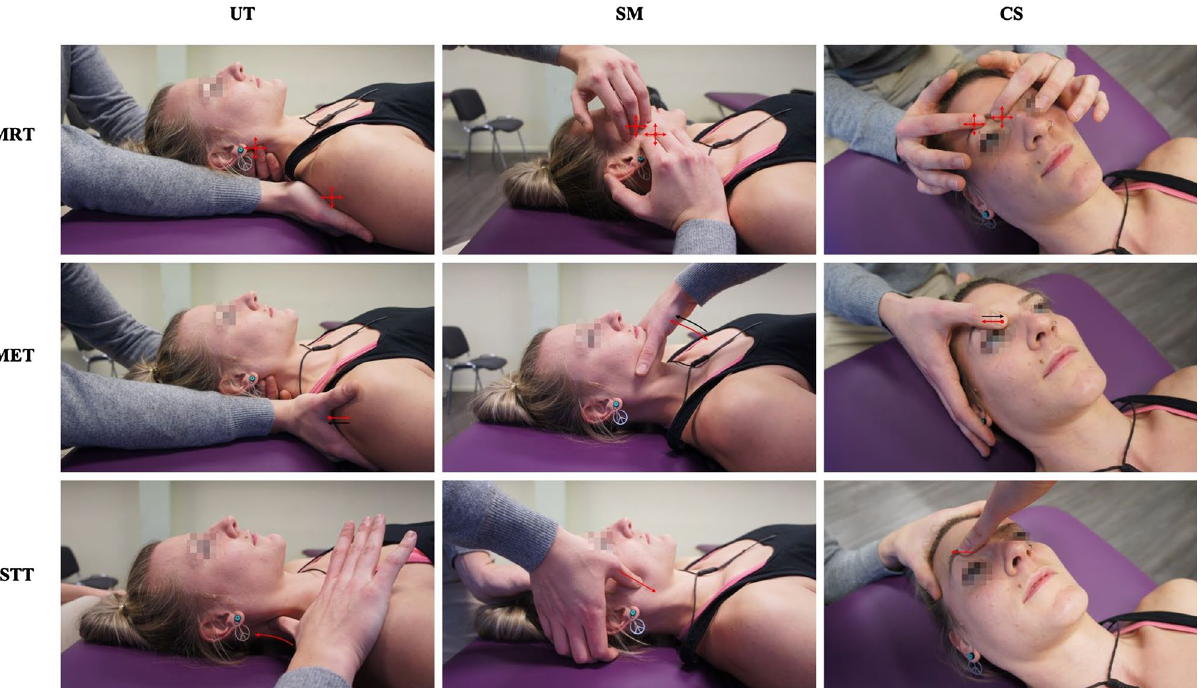
Figure 1. Osteopathic techniques; Legend: red arrows = therapists’ motion; black arrows = participants’ motion; four-headed arrows = motion applied in all directions; Abbreviations: MRT = myofascial release technique; MET = muscle energy technique; STT = soft tissue technique; UT = upper trapezius muscle; SM = superficial masseter muscle; CS = corrugator supercilii